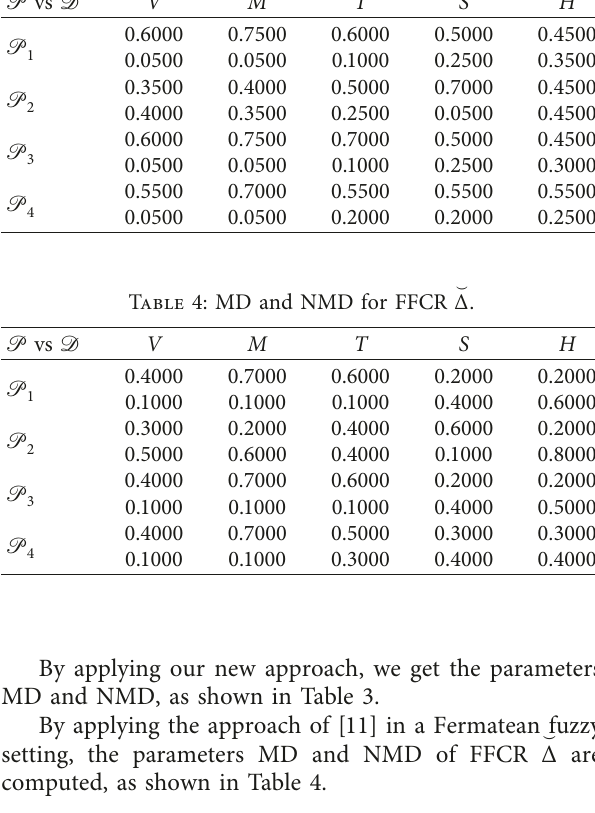
Table 3: MD and NMD for FFCR Π ⌣ . P vs D